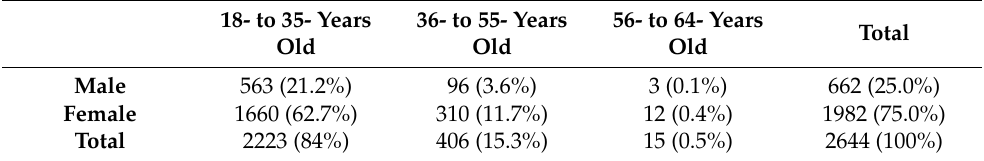
Table 1. Age group and gender distribution of the overall